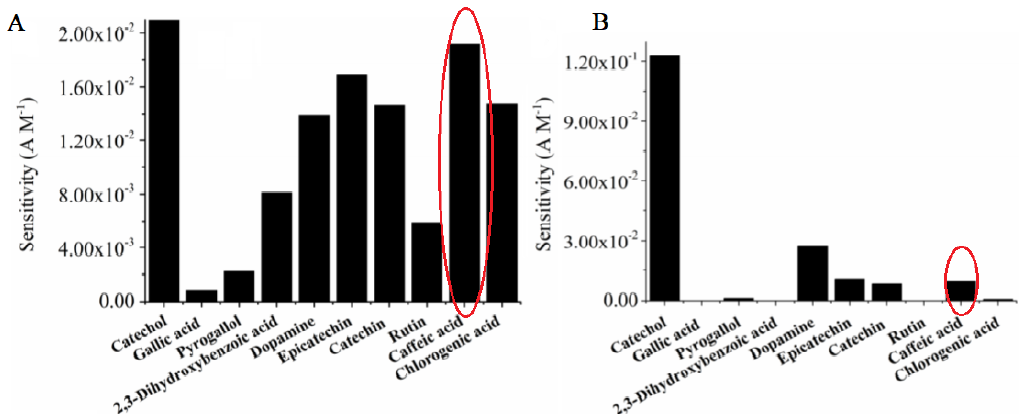
Figure 3. Sensitivity of Lacc ‐ ( A ) and Tyr ‐ ( B ) based biosensors to tested analyzes [90]. In red elipses are highlighted the results obtained in the case of the CA detection. Reprinted with the permission of the